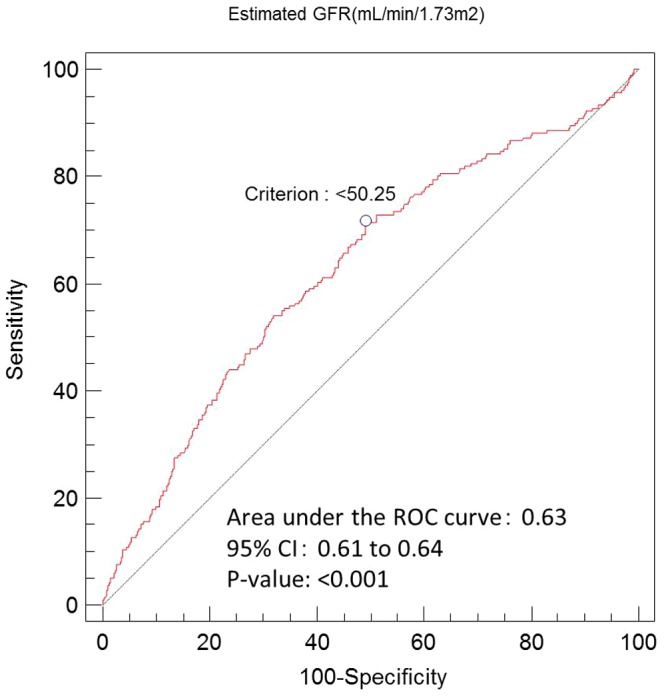
Evaluation of the receiver operating characteristic curve for renal dysfunction.The area under the curve was 0.63 (95% confidence interval = 0.61–0.64, p<0.001), and the cut-off value for the greatest sensitivity and specificity was 50.25 mL/min/1.73 m2. GFR, glomerular filtration rate; CI, confidence interval; ROC, receiver operating characteristic.